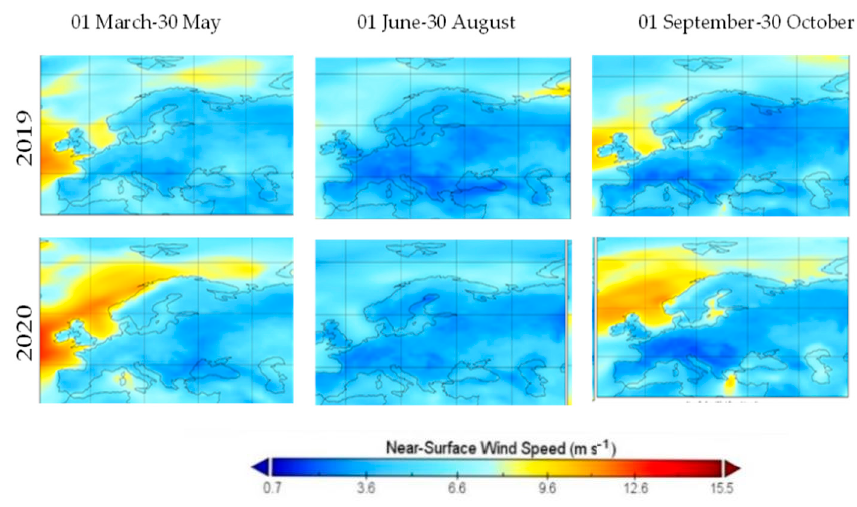
Figure 6. Mean of ground level wind speed over Europe in three periods, 2019 and 2020. Mean temperature over Europe registered lower values in 2020 than 2019 in spring, summer and autumn, with an exception in July, when the Balkan region registered higher values in 2020 than 2019, as shown in Figure 7. While cold weather tends to foster the accumulation of PM and CO and make pollutants more visible, warm weather increases the amount of O 3 concentration, along with PM 2.5 , PM 10 and CO, when associated with natural forest fires. Moreover, CO tends to decrease when temperatures are high. The lower value of near-surface temperatures justifies, in part, the higher visibility of PM 2.5 , PM 10 and CO.